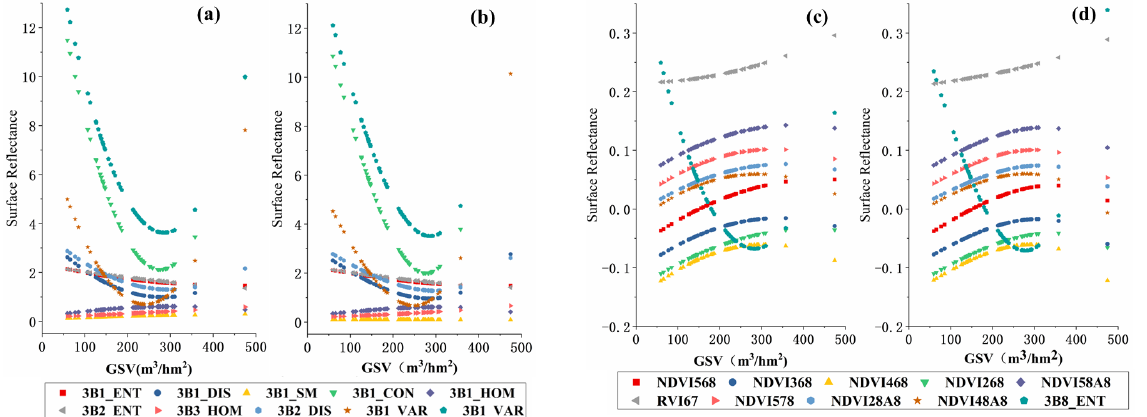
Figure 5. The fitted curves of the top ten features extracted from GF-1 images ( a , b ) and Sentinel-2 images ( c , d ) using the quadratic model and the spherical model, respectively. Table 3. Spectral saturation levels of the top ten feature variables using two models for different